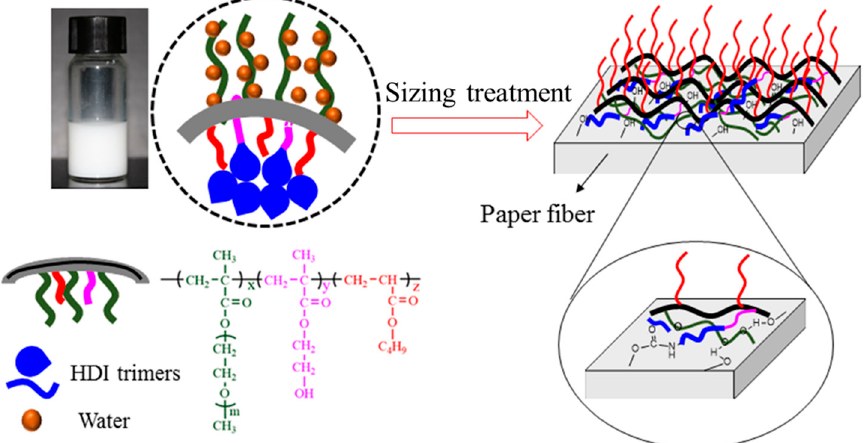
Figure 10. Schematic diagram of site-directed reaction of active material and paper